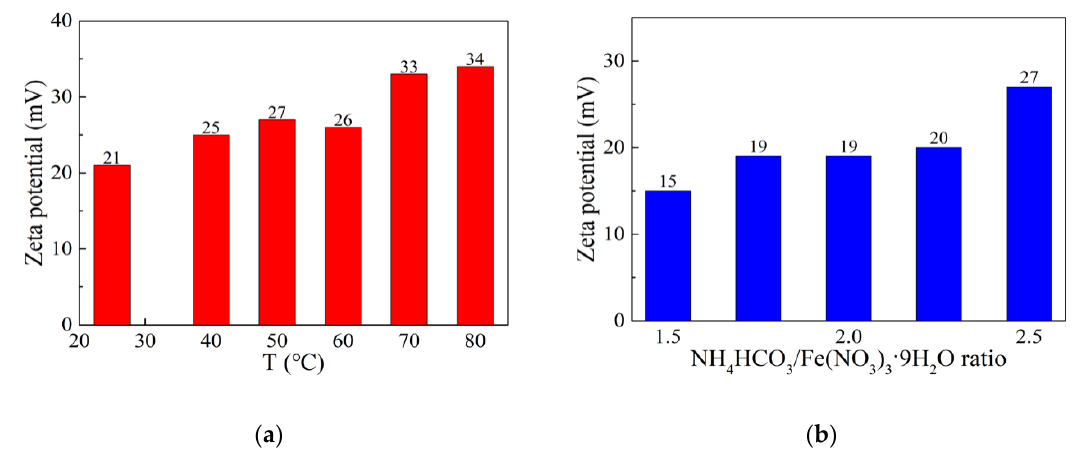
Figure 4. The Zeta potential of iron sols: ( a ) Zeta potential vs. holding temperature; ( b ) Zeta potential vs. NH 4 HCO 3 /Fe(NO 3 ) 3 ·9H 2 O ratio.